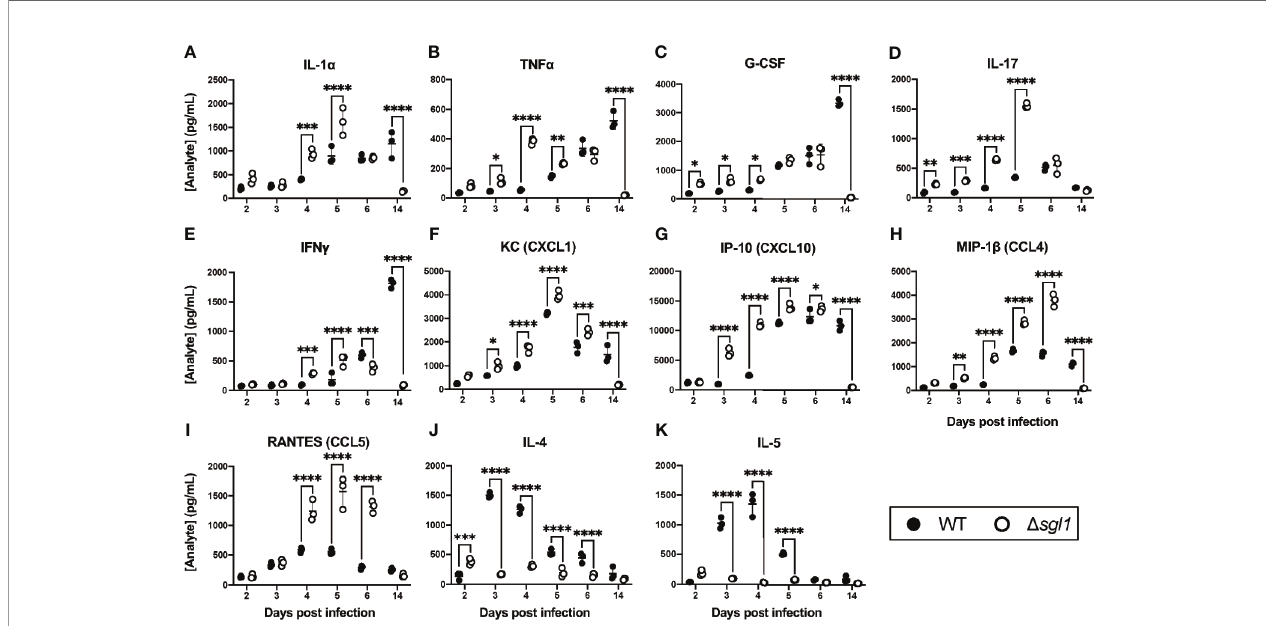
FIGURE 2 | C. neoformans (Cn) D sgl1 induces a pro-In fl ammatory lung cytokine microenvironment in the host. CBA/J mice were intranasally infected with 5x10 5 CFU of either WT or Cn D sgl1. Total lung tissue homogenates (n=3 mice/strain/timepoint) were analyzed using a Multiplex Elisa Array on days 2, 3, 4, 5, 6. and 14 post infection for various cytokines (A – E, J, K) and chemokines (F – I) . Signi fi cance was determined by a two-way ANOVA using S ̌ ı ́ da ́ k ’ s multiple comparisons test for P value adjustment. Graphed data represents the mean +/- SD, and signi fi cance is denoted as * P < 0.05; ** P < 0.01; *** P < 0.005; **** P <